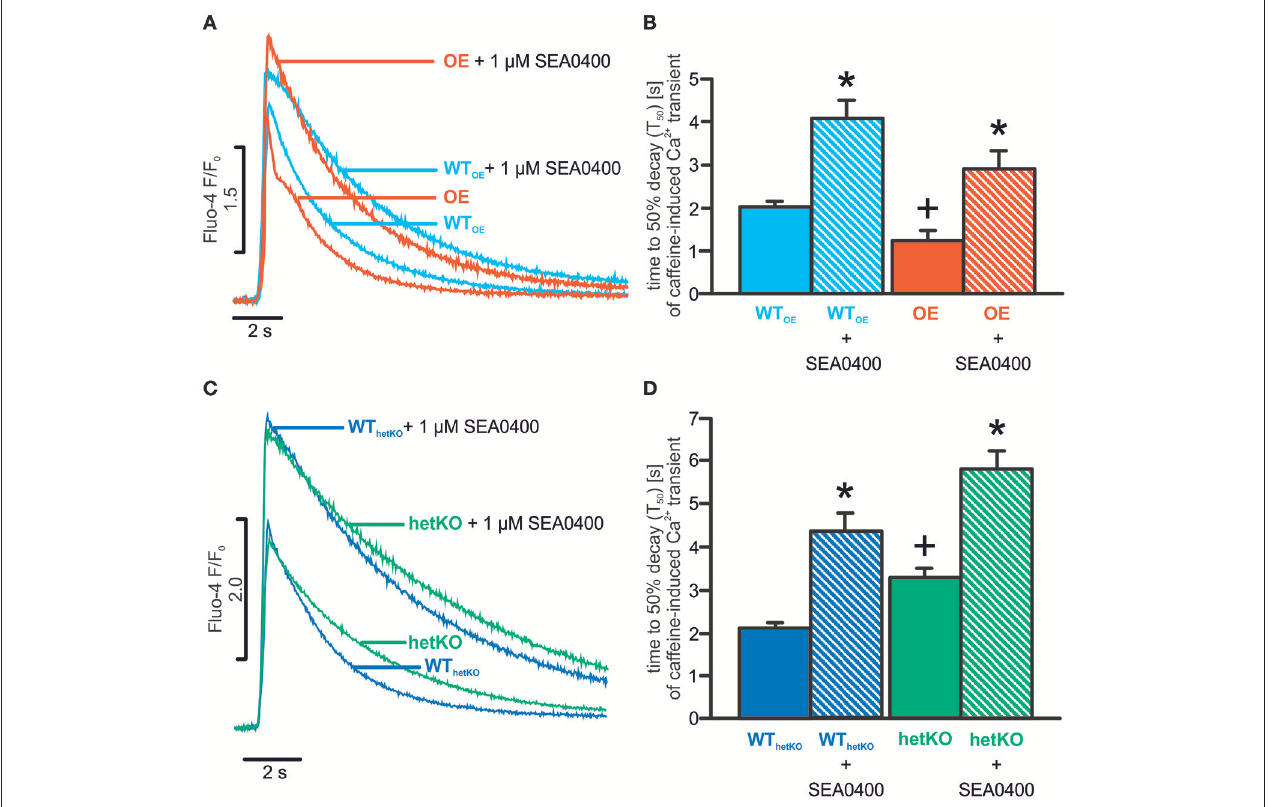
FIGURE 1 | SEA0400 mediated NCX forward mode inhibition in caffeine application experiments. Representative tracings of caffeine-induced Ca 2 + transients illustrate the different decay rates in OE (A) , hetKO (C) and respective WTs as a direct measure of NCX-mediated Ca 2 + removal under basal conditions and during NCX inhibition by SEA0400. Quantification of time to 50% decay (T 50 ) of caffeine-induced Ca 2 + transients confirmed increased NCX forward mode function in OE (B) and decreased in hetKO (D) , and verified NCX forward mode inhibition by SEA0400 in all investigated groups but to different levels. * p < 0.05 vs. basal; + p < 0.05 OE/hetKO vs. WT OE /WT hetKO basal; ANOVA on ranks